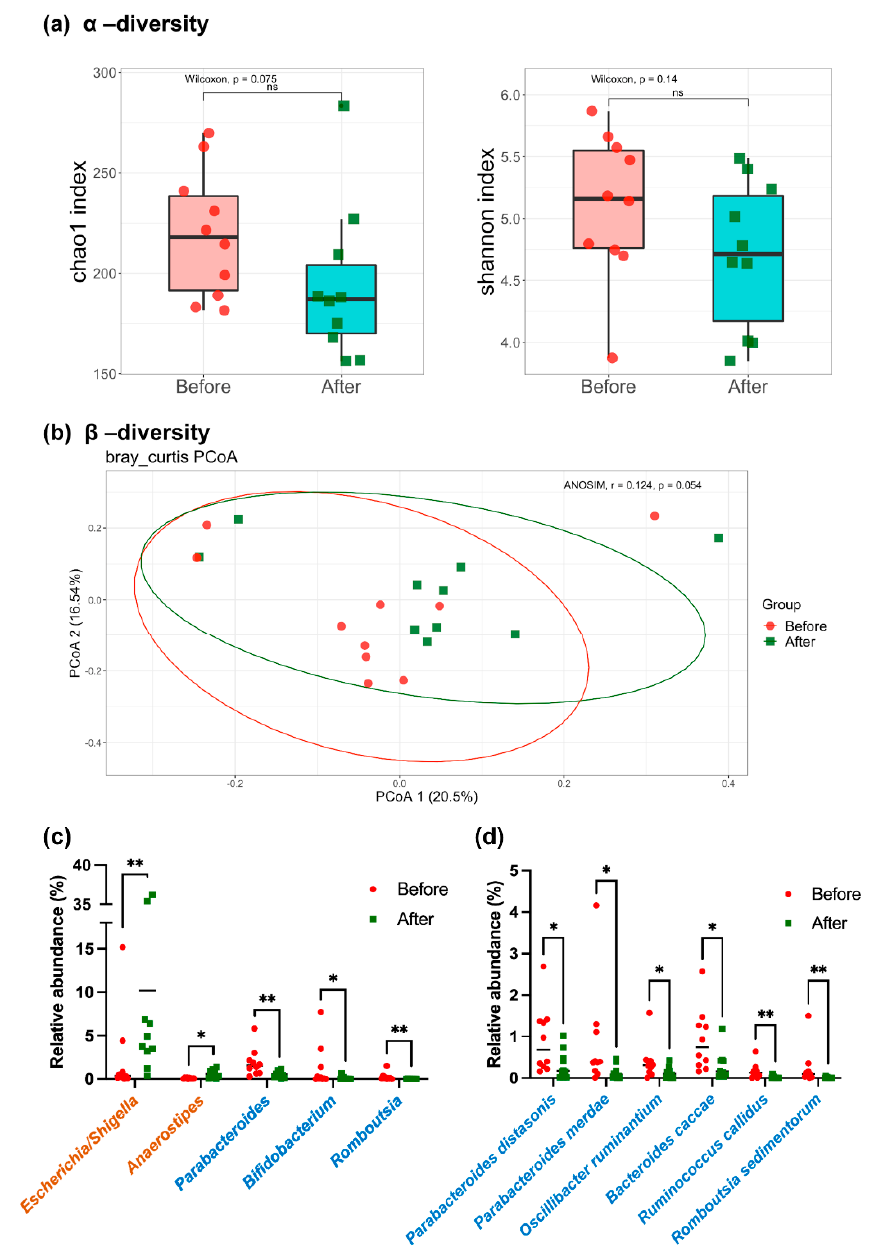
Figure 1. Oral YH1 modulated the composition of gut microbiota in men with type 2 diabetes and hyperlipidemia. ( a ) Chao1 and Shannon indices were used to analyze the α -diversity of fecal microbiota before (red circles) and after (green squares) YH1 treatment in ten patients. ( b ) The β -diversity of fecal microbiota at baseline and after YH1 treatment was determined by principal coordinate analysis (PCoA) based on the Bray-Curtis dissimilarity index. Significant changes in the fecal microbiota at the ( c ) genus and ( d ) species level before and after YH1 treatment are presented. Genus and species names in brown or blue font represent significant enrichment or depletion of bacteria after YH1 treatments, respectively. Statistical significance (* p < 0.05; ** p < 0.01) were detected by the Wilcoxon signed-rank